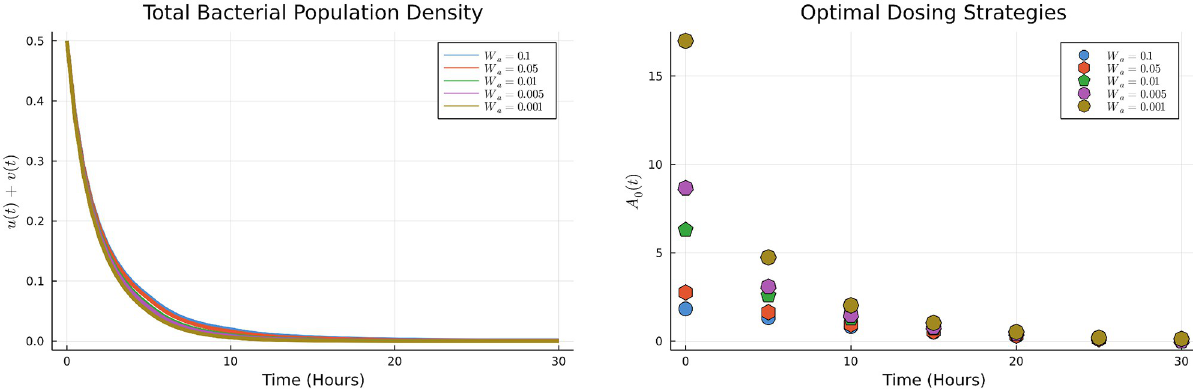
Fig 6. Optimal dosing strategies and bacterial population corresponding to various cost sensitivity parameter W a